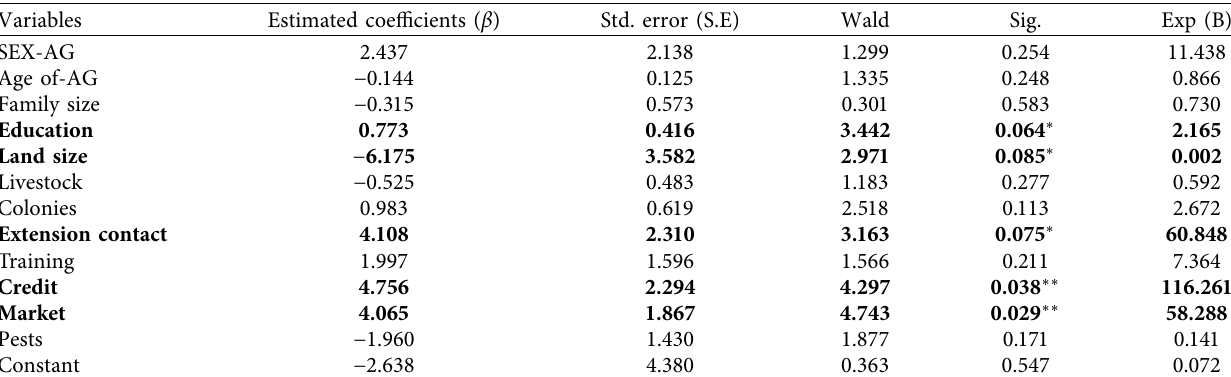
Table 18: Model estimates for factors affecting the level of adoption of modern beekeeping technology by farmers.